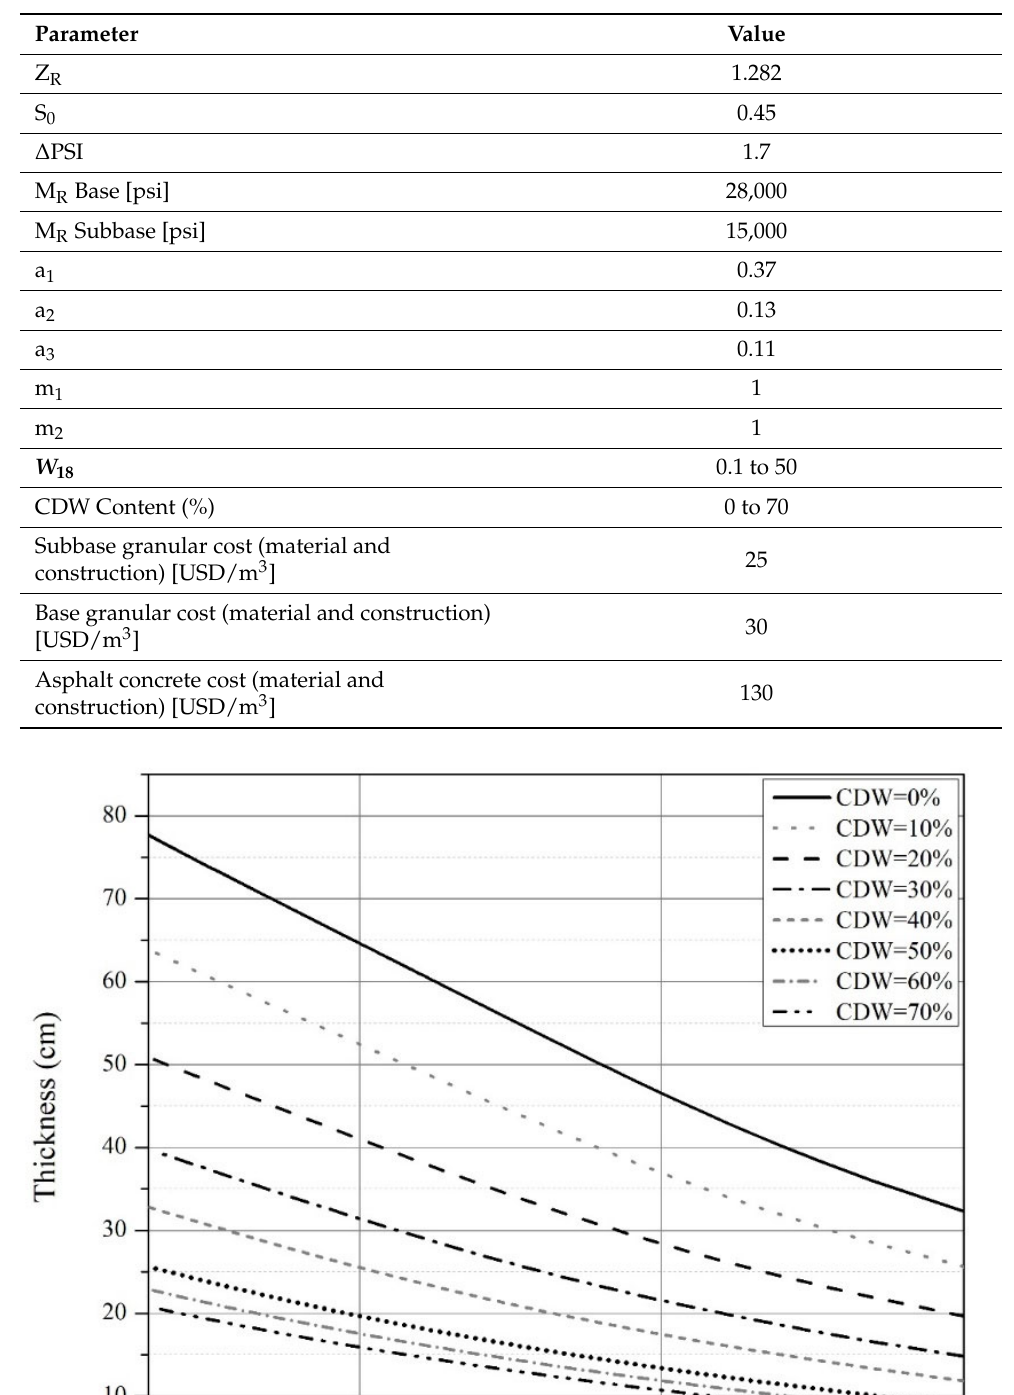
Table 7. AASHTO-93 method design parameters.